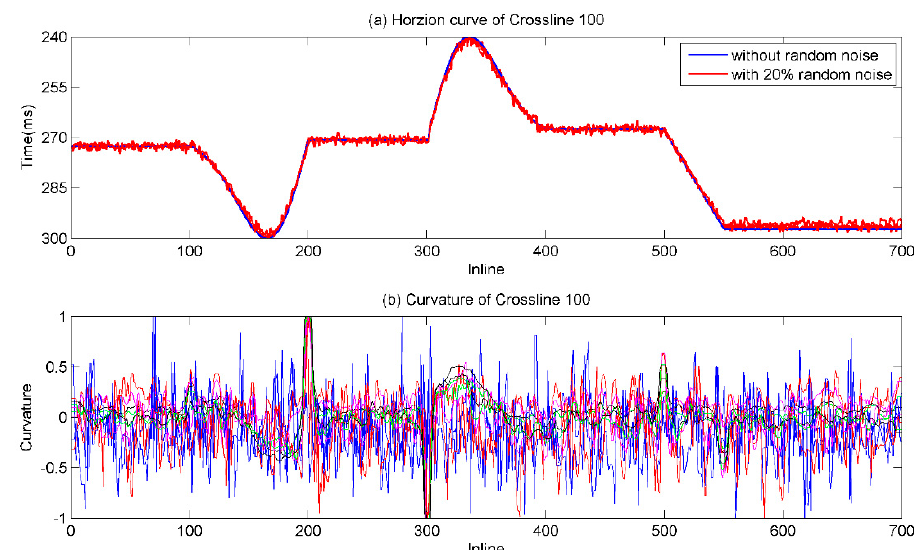
Figure 8. Horizon curve and mean curvature attribute with 20% noise: ( a ) Horizon curve and ( b ) mean